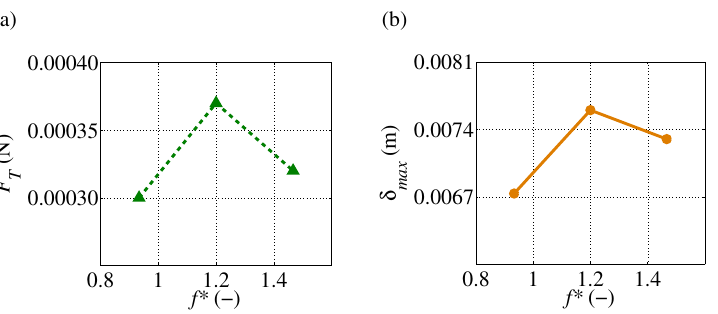
Figure 5. ( a ) Mean thrust. ( b ) The maximum relative deformation of trailing edge δ max for different non-dimensional frequencies f ∗